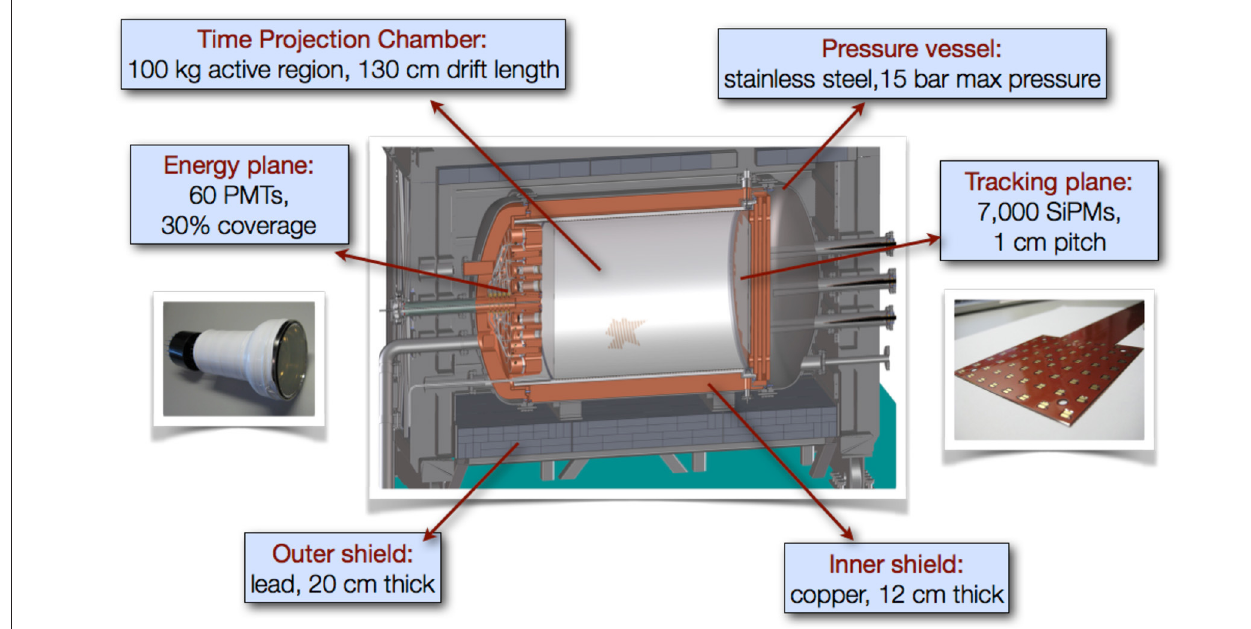
FIGURE 10 | The NEXT-100 detector.